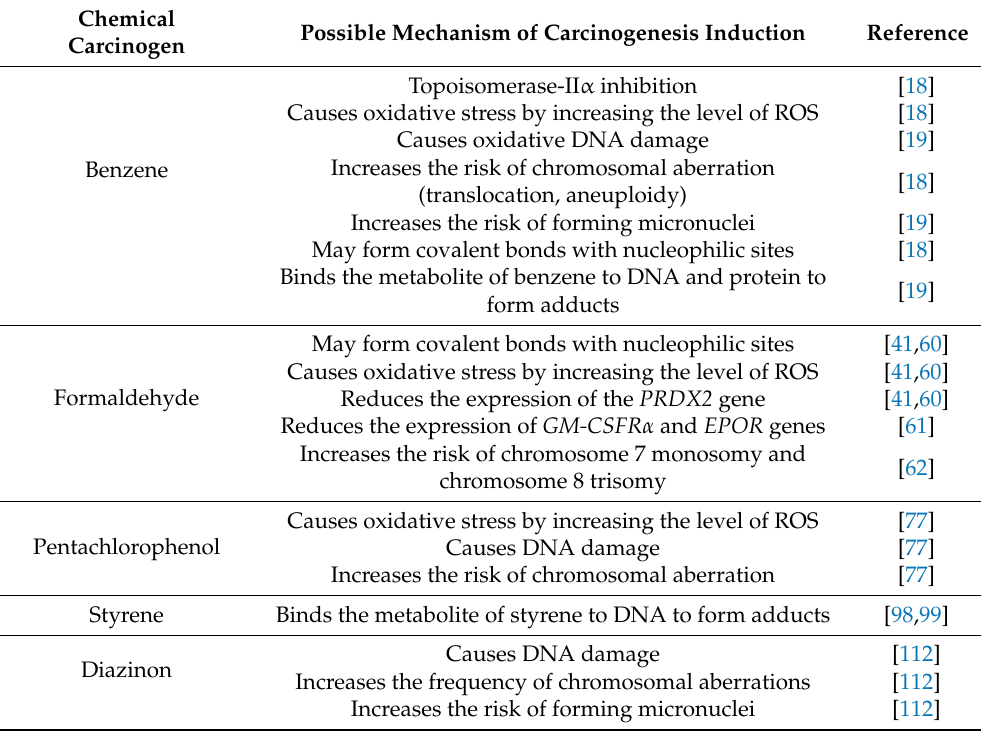
Table 2. Possible mechanisms of action of leukemia-inducing chemical carcinogens.